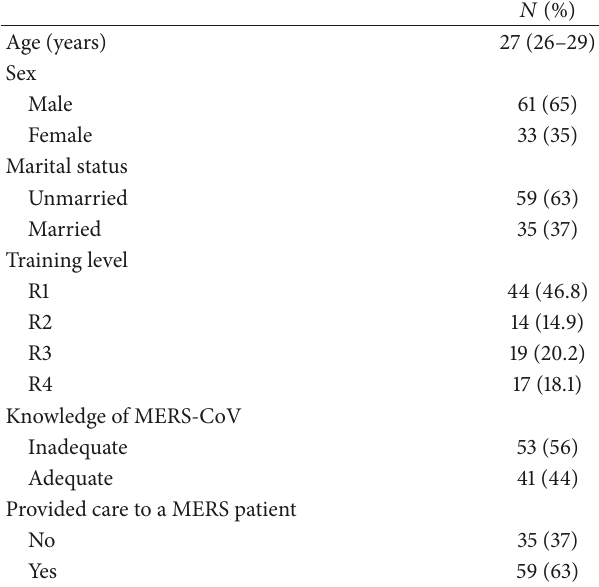
Table 1: The participants’ demographic